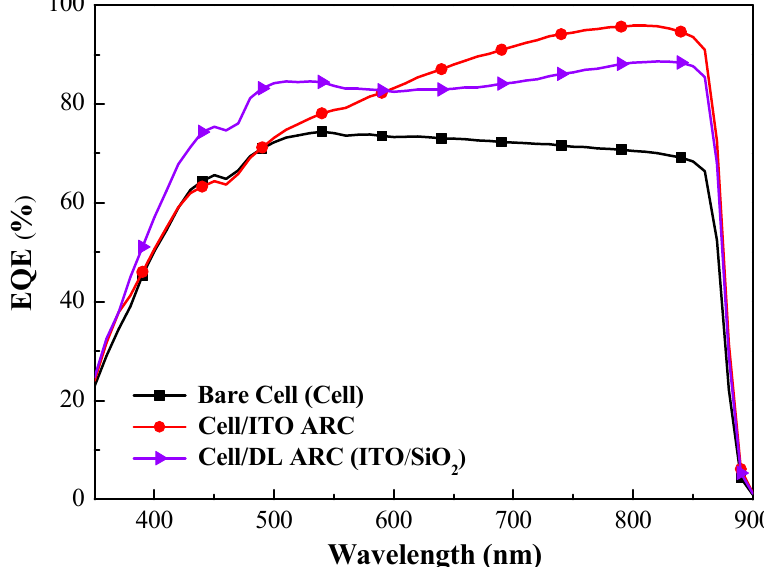
Figure 8. EQE response of bare-type GaAs single-junction solar cells and GaAs solar cells coated with layer of ITO or ITO / SiO 2